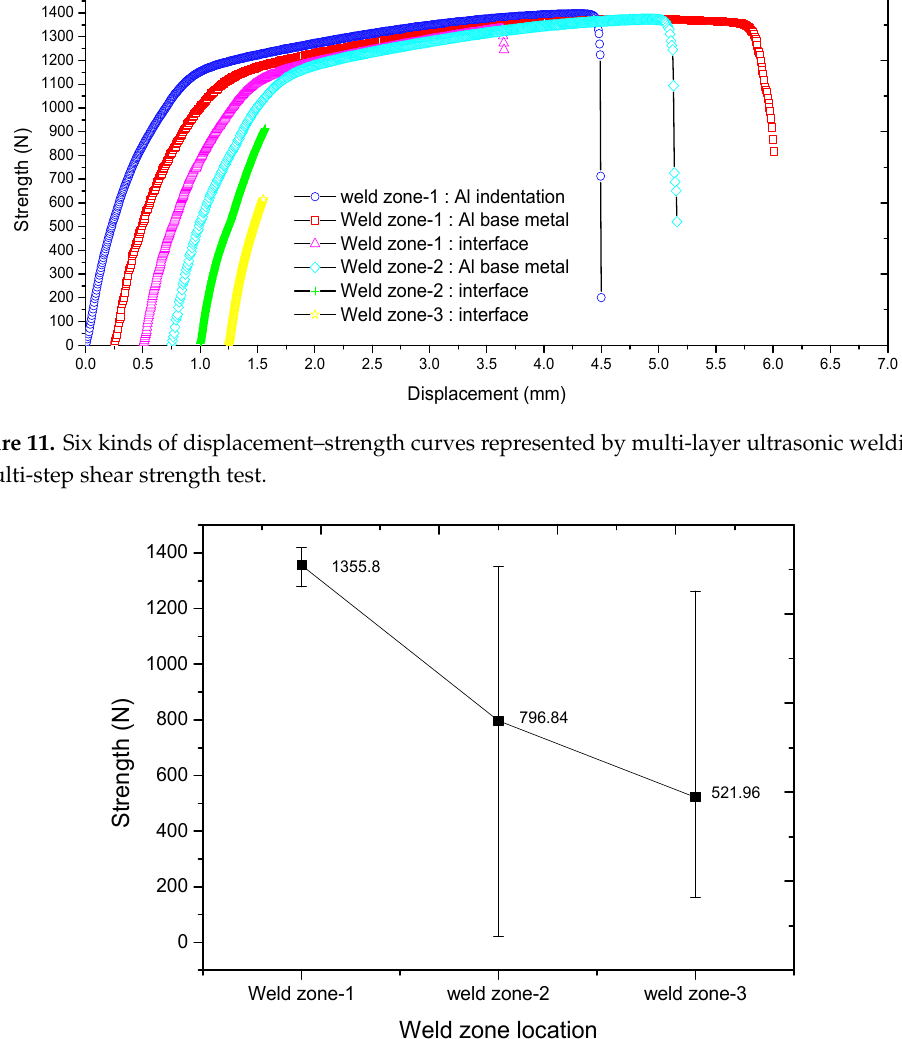
Figure 12. Average strength according to weld zone location.